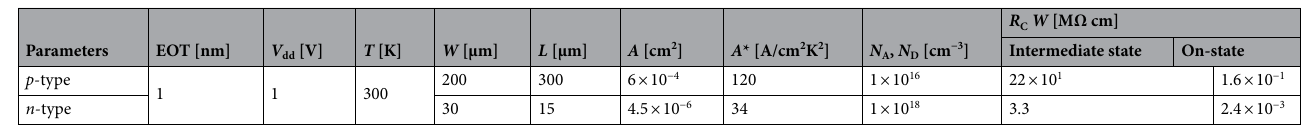
Table 1. Device parameters for ternary device modeling, where A * is the Richardson constant and N A and N D are the charge concentrations of the semiconductors.